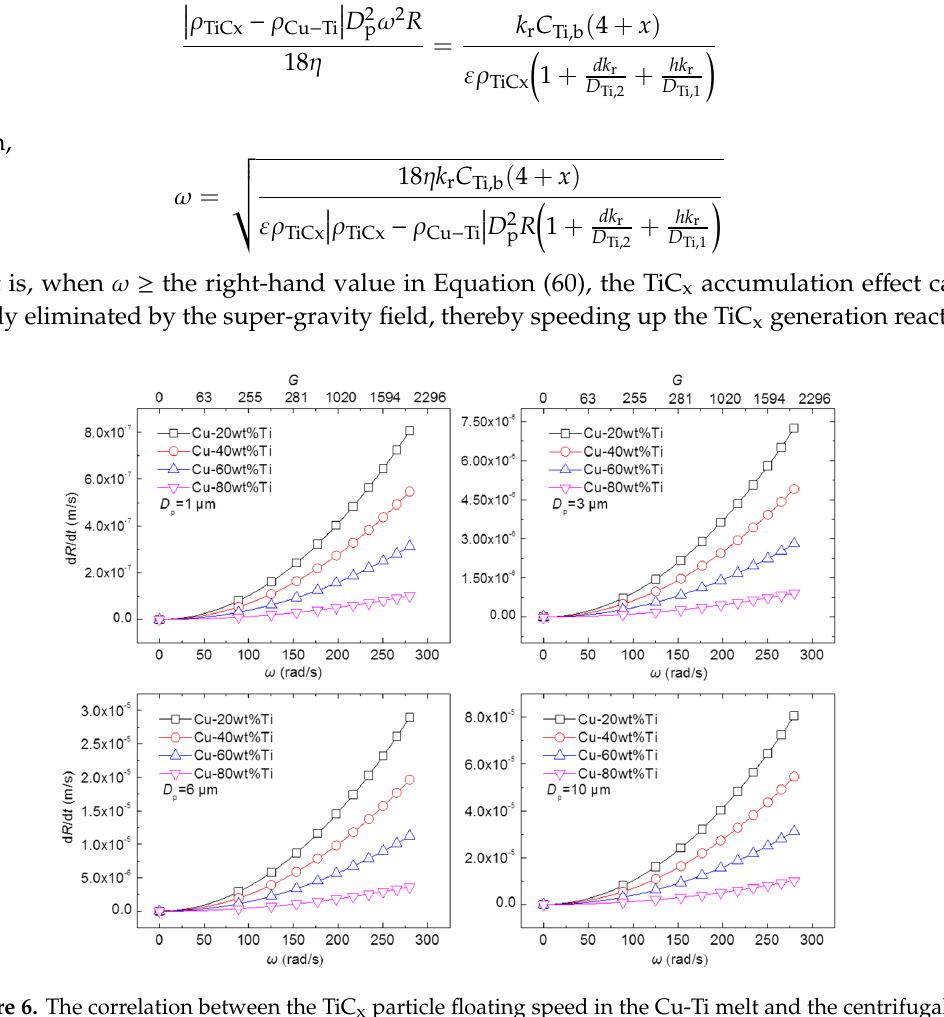
Table 1. The values of ρ Cu-Ti , △ ρ , and η Cu-Ti with different Cu-Ti proportions (e.g., “Cu-20 wt.% Ti” means the weight percentage of Ti in the Cu-Ti alloy is 20wt.%).